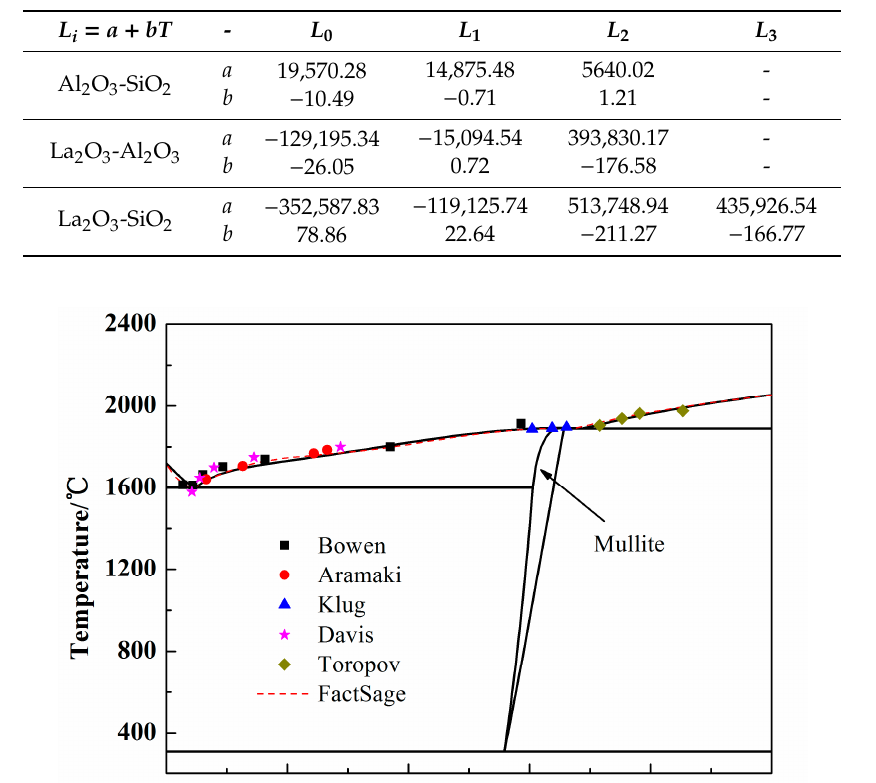
Table 2. Optimization parameters of the binary systems.